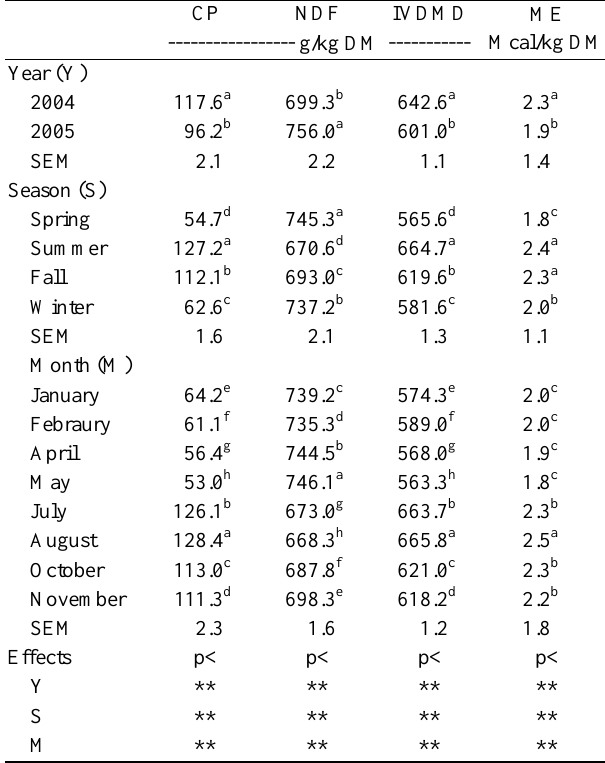
Table 1. Chemical composition of the diet consumed by grazing steers CP NDF IVDMD ME